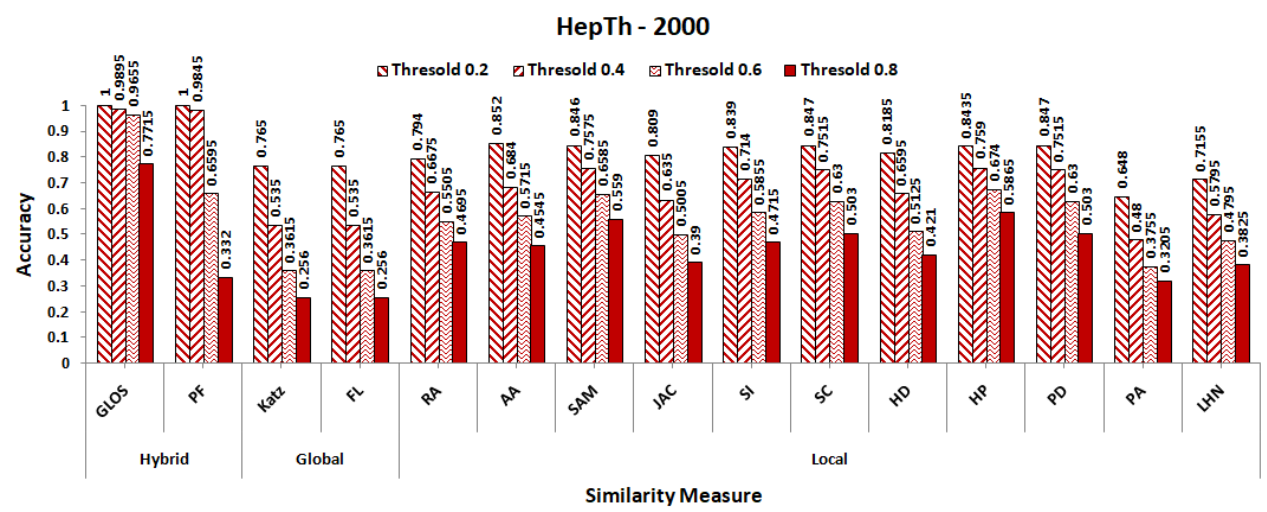
Figure 21. Comparisons of similarity measures on HepTh-2000 edge list from HepTh dataset Table 7. The table presents the results of accuracy on HepTh Dataset. Where, (T) represents the threshold, High represents the similarity measures obtaining highest accuracy, 2nd High corresponds to the similarity measures obtained second highest accuracy and low represents the similarity measures obtained lowest accuracy. The red color shows the Global approaches, the blue color shows the Local approaches and the green color shows the Hybrid